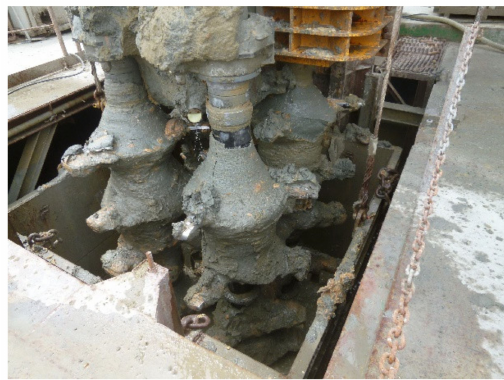
Figure 7. Example of “entrained mixing